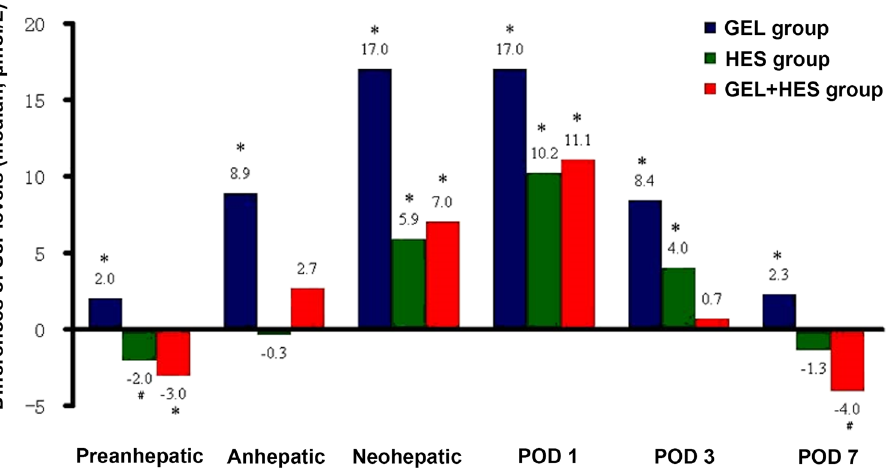
Figure 2: Comparisons of intraoperative and postoperative Scr levels ( μ mol/L ) with the preoperative baseline levels. POD: postoperative